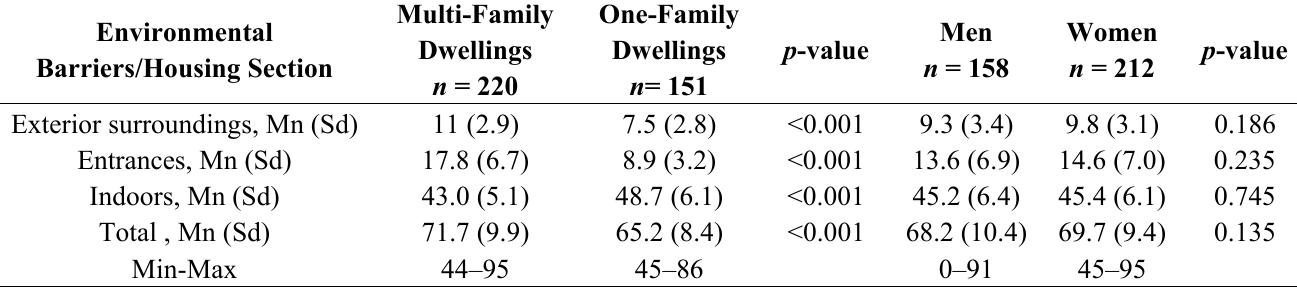
Table 4. Number of environmental barriers in relation to type of housing and sex, N =